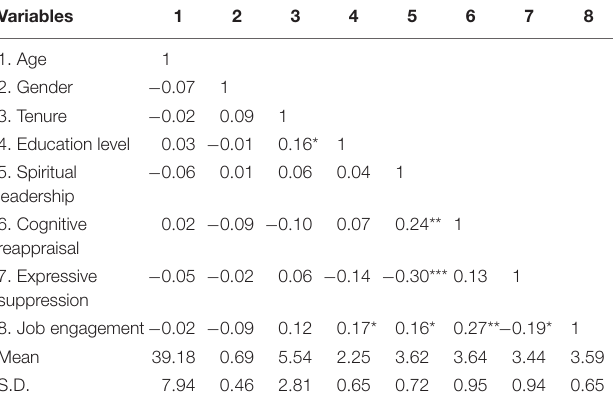
TABLE 1 | Correlation matrix ( N = 203).